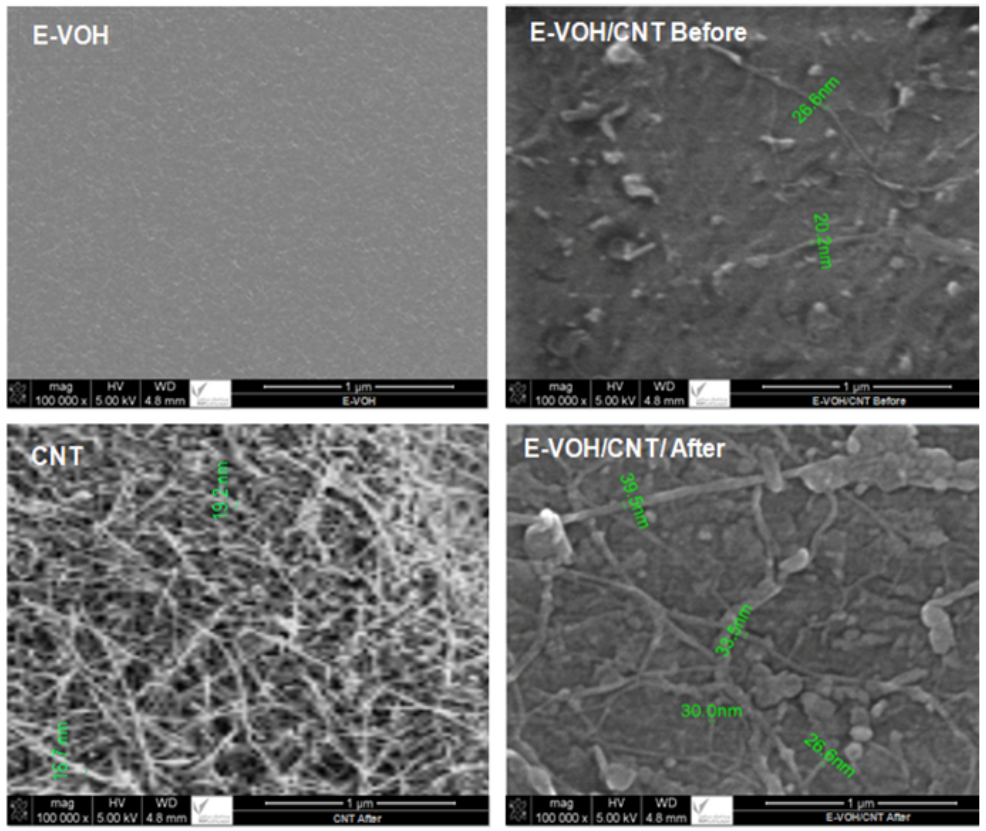
Figure 1. Scanning electron microscopy (SEM) images of Poly(ethylene-co-vinylalcohol) (E-VOH) and poly (vinyl alcohol-co-ethylene)(E-VOH / CNT) membranes before and after use in the pervaporation process.